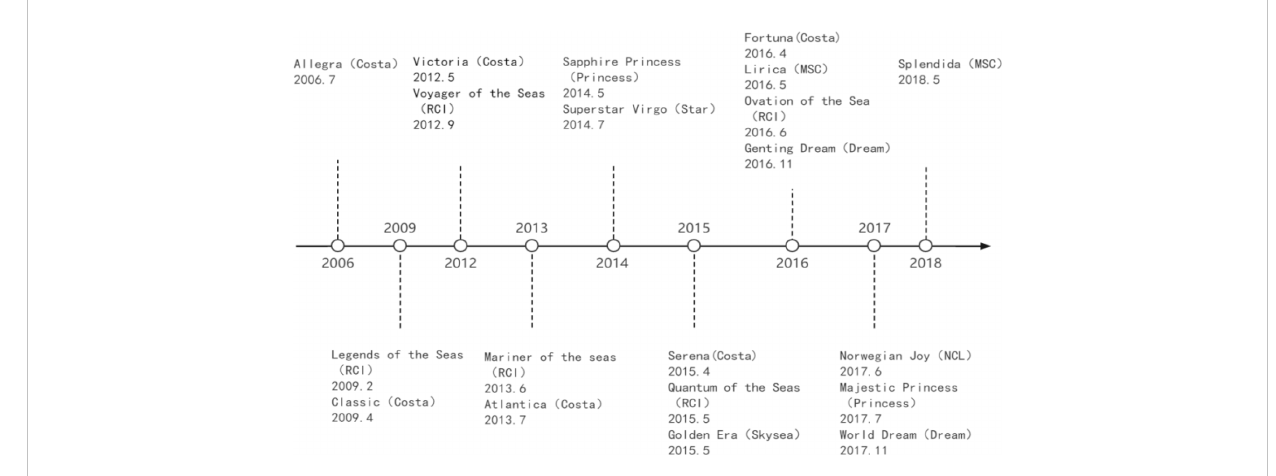
FIGURE 4 The timeline of cruise companies and ships operating in China.